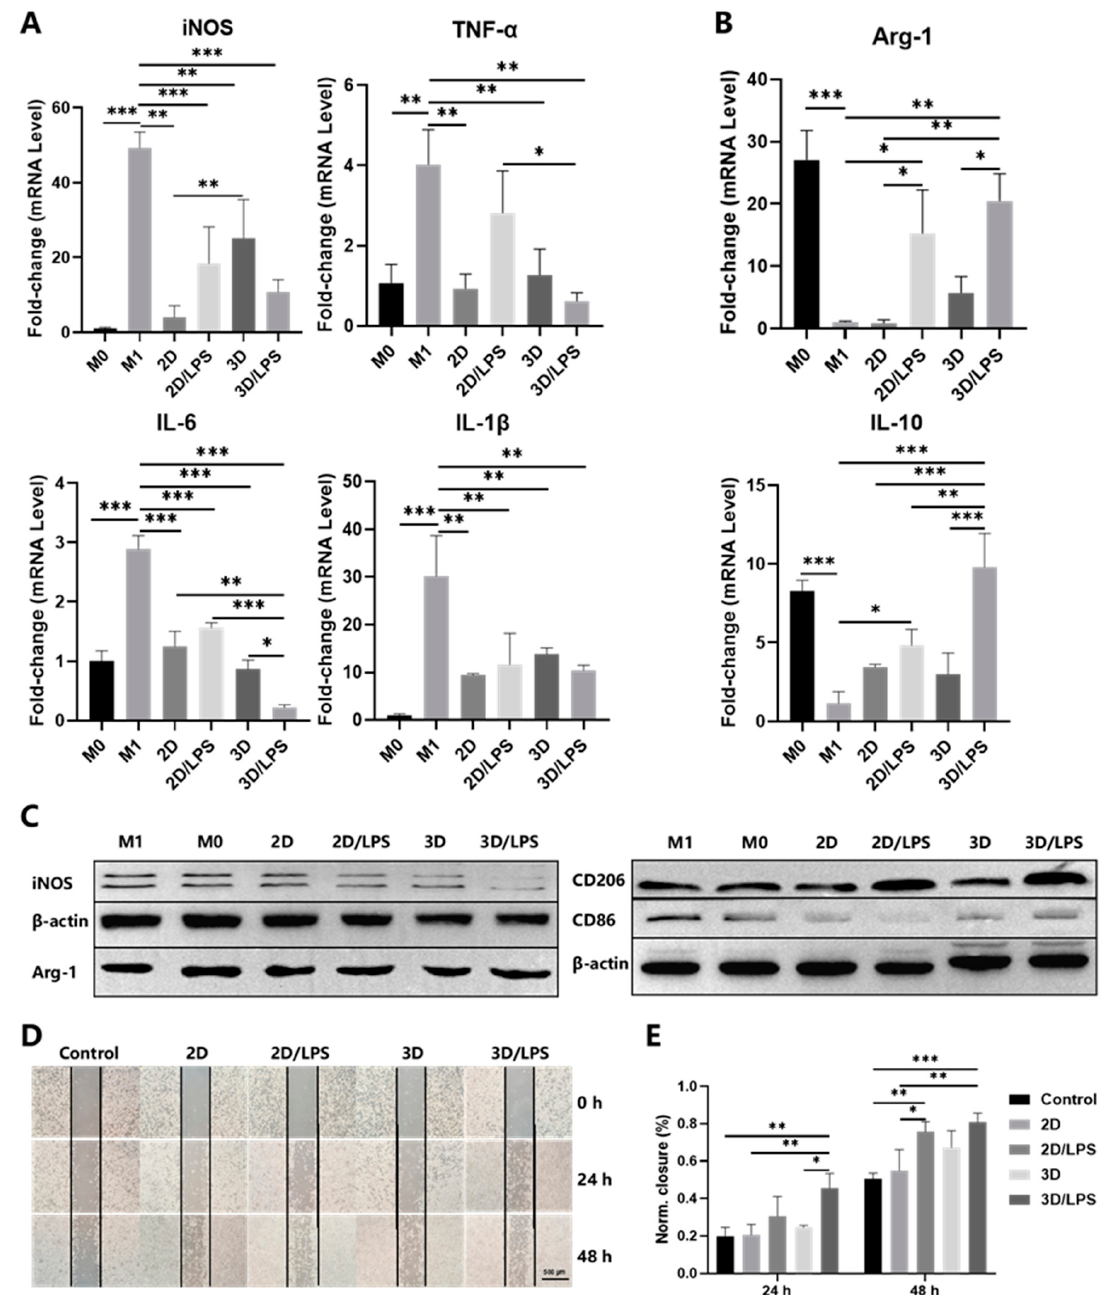
Figure 7. Effects of the secretome on macrophage polarization and migration. ( A ) qRT-PCR: iNOS , TNF- α , IL-6 and IL-1 β mRNA expression in M0, M1 and 2D-, 2D/LPS-, 3D-, 3D/LPS-group-derived- secretome-cultured M1 macrophages. ( B ) qRT-PCR: Arg-1 and IL-10 mRNA expression in M0, M1 and 2D-, 2D/LPS-, 3D- and 3D/LPS-group-derived-secretome-cultured M1 macrophages. ( C ) Western blot: iNOS, Arg-1, CD86 and CD206 expression in M0, M1 and 2D-, 2D/LPS-, 3D-, 3D/LPS-group- derived-secretome-cultured M1 macrophages. ( D ) Wound healing of macrophages cultured with FBS-free medium (Control) and 2D-, 2D/LPS-, 3D- and 3D/LPS-group-derived secretome for 0, 24 and 48 h under a microscope; scale bar—500 µm. ( E ) Wound closure of macrophages cultured with FBS-free medium (Control) and 2D-, 2D/LPS-, 3D-, 3D/LPS-group-derived secretome for 0, 24 and 48 h. * p < 0.05; ** p < 0.01; *** p < 0.001. We performed an immune cytokines assay (48 cytokines) on 2D-, 2D/LPS-, 3D- and 3D/LPS-group-derived secretome to study whether the di ff erent treatments translated into an altered paracrine content in the corresponding secretome. The expression levels of di ff erent cytokines are summarized in Figures 8, 9 and S3. Of the 48 cytokines examined,